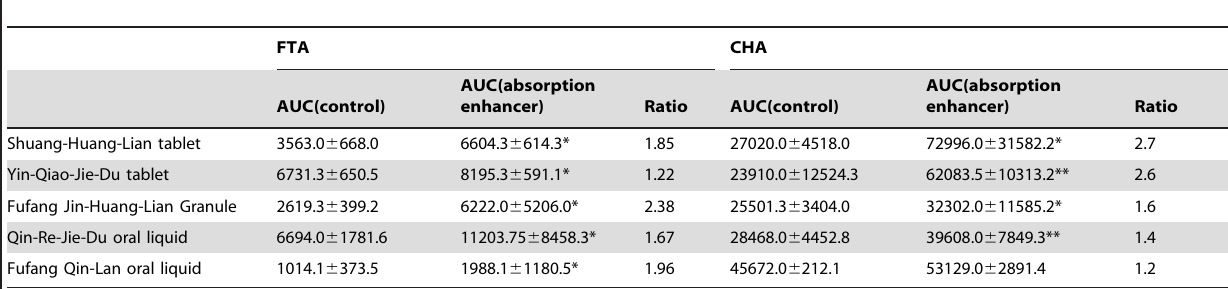
Table 5. Effects of COS at the dosage of 25 mg/kg on the oral bioavailability of FTA and CHA in Flos Lonicerae - Fructus Forsythiae herb couple